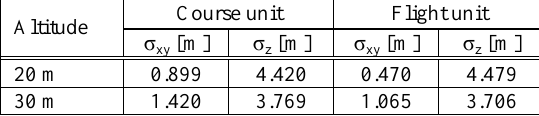
Table 5. Accuracy for a given condition of GNSS